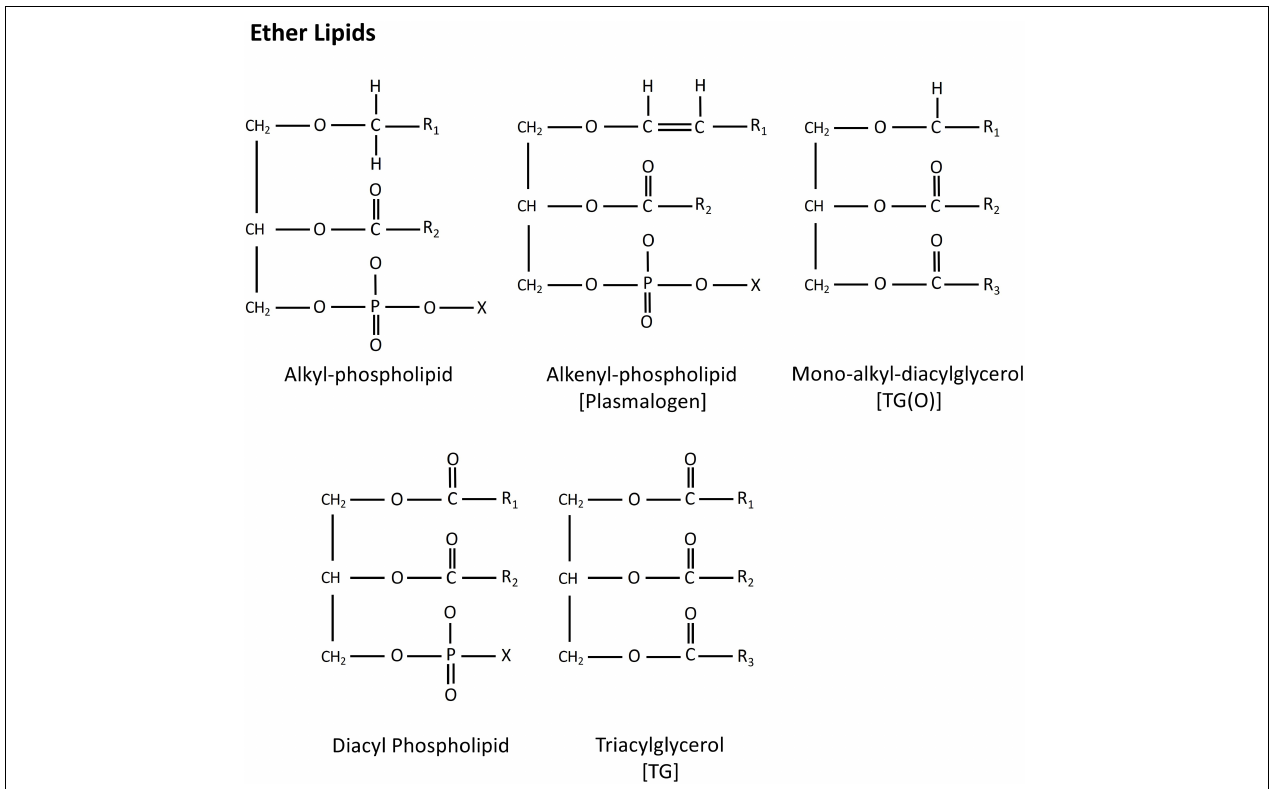
FIGURE 1 | Chemical structure of alkyl-, alkenyl- and mono-alkyl-ether lipids. Diacyl phospholipid and triacylglycerol exhibits typical structure of a